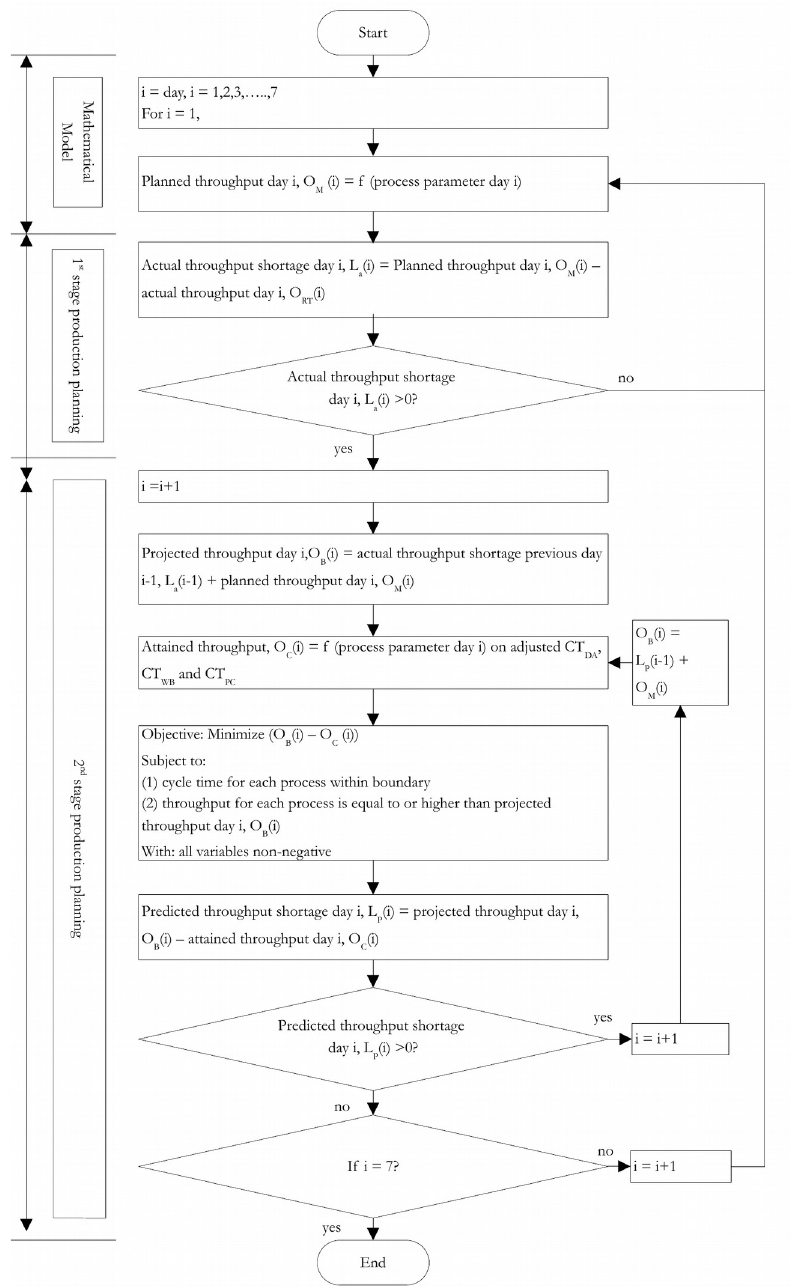
Figure 1. The two-stage production planning model for a single